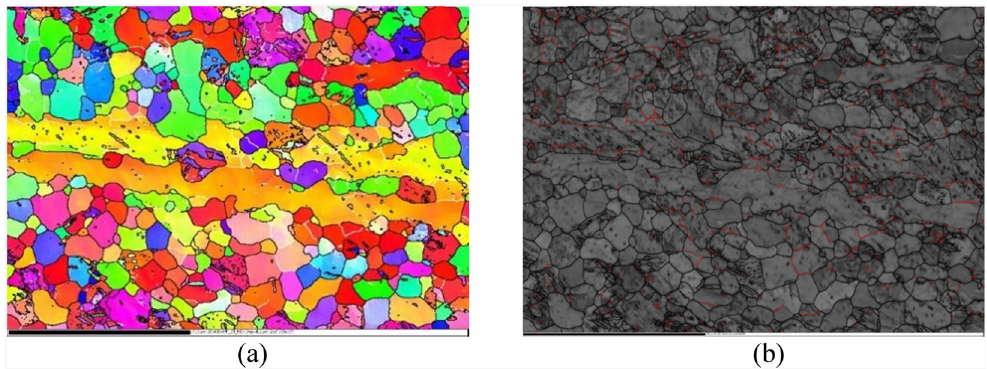
Figure 3: ( a ) IPF map and ( b ) BC map with high - angle boundaries > 15° in black lines and low - angle boundaries 3 – 15° in red lines, superimposed for the AA pure Mg.